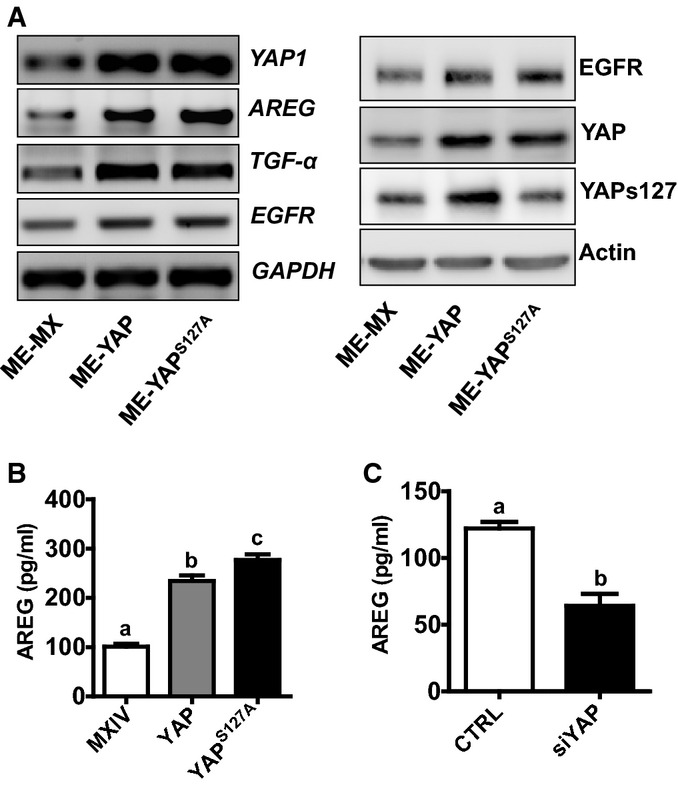
YAP regulated EGFR, AREG, and TGF-α expression in cervical cancer cell
RT–PCR (left) and Western blot (right) were used to determine the expression of EGFR, AREG, and TGF-α in ME180-MXIV, ME180-YAP, and ME180-YAPS127A cells. GAPDH and actin were used as controls.

The concentration of AREG in cell culture medium from ME180-MXIV, ME180-YAP, and ME180-YAPS127A cells. The concentration of AREG in the medium was determined by AREG ELISA kit. Each bar represents mean ± SEM (n = 5). Bars with different letters are significantly different from each other (ME-MX vs. ME-YAP, P < 0.0001; ME-MX vs. ME-YAPS127A, P < 0.0001).

The concentrations of AREG in ME180 cells with or without siYAP treatment. ME180-CTRL and ME180-siRNA cells were incubated in the FBS 1% medium for 48 h. Each bar represents mean ± SEM (n = 5). Bars with different letters are significantly different from each other (P = 0.0006).
Data information: Quantitative data in (B) were analyzed for significance using one-way ANOVA in GraphPad Prism 5 with Tukey’s post hoc tests. Data in (C) were analyzed for significance with unpaired t-test in GraphPad Prism 5 with Welch’s correction.